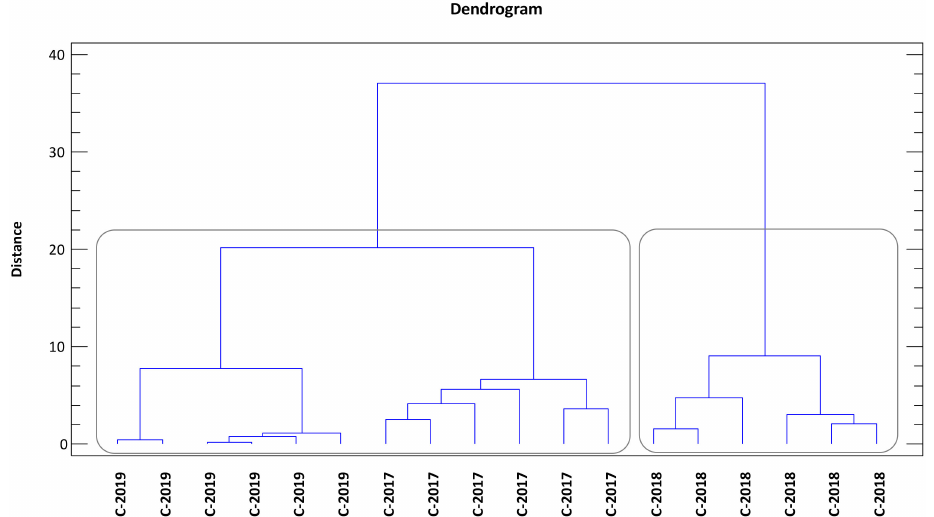
Figure 2. Dendogram grouping ‘Mansa de Figueiredo’ EVOOs according to the Euclidean distance by Ward’s method. C-2017: EVOOs from 2017 campaign; C-2018: EVOOs from 2018 campaign; C-2019: EVOOs from 2019